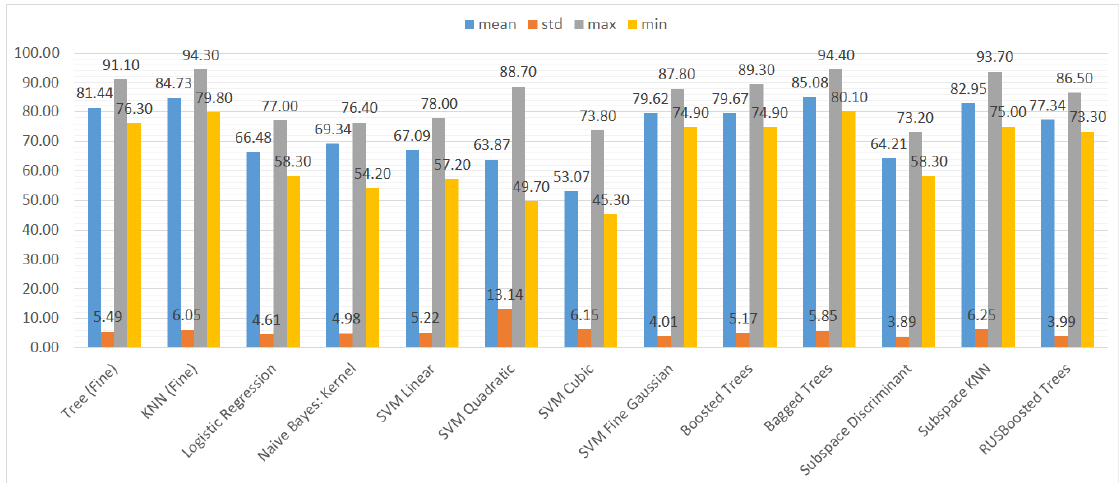
Figure 10. Mean, standard deviation, maximum, and minimum of the accuracy results for different types of classifiers.